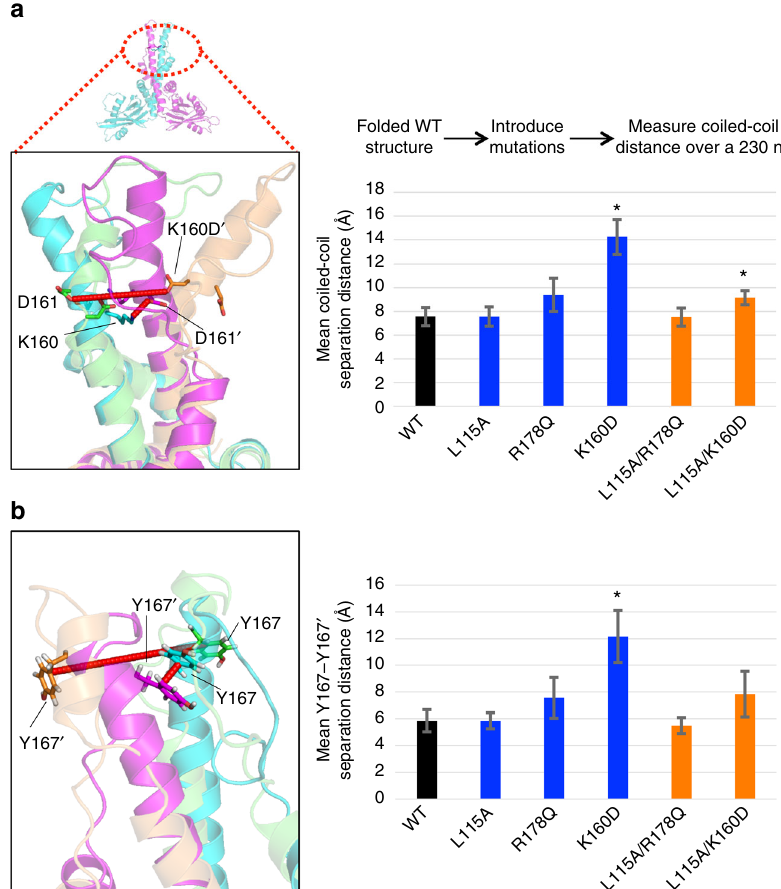
Fig. 6 Molecular dynamics simulations of the dimer interface for XLF WT and several mutants. a We measured the distance between the coiled-coil domains of each monomer of the XLF dimer for WT and mutant dimers from individual replicates of 230 ns simulations. A representative fi gure (left) shows the extreme distances of the separation between the coiled-coil domain observed in simulations: the WT structure (cyan and magenta dimer pair) in which the dimer interface is kept intact, and the K160D mutant (green and orange dimer pair) in which the dimer interface is disrupted. We observe an increase of ~6 Å in the distance between the coiled-coil interface of each monomer in the K160D mutant compared to the wild type. Also shown (right) are the distances for the coiled-coil domain, centered near residue K160, as the mean of replicates. Error bars show the 95% con fi dence interval from a one- directional Student ’ s t -test distribution. Asterisks denote signi fi cant difference compared to the WT. b Shown (left) are representative extreme distances for the pi stacking interaction of Y167 and Y167 ′ in the WT (cyan and magenta dimer pair) and the R178Q mutant dimer (green and orange dimer pair). Also shown (right) is the distance between the center of mass of Y167 and Y167 ′ , plotted as mean of replicates. Error bars represent the 95% con fi dence interval from a one-directional Student ’ s t -test distribution. Asterisks denote signi fi cant difference compared to the